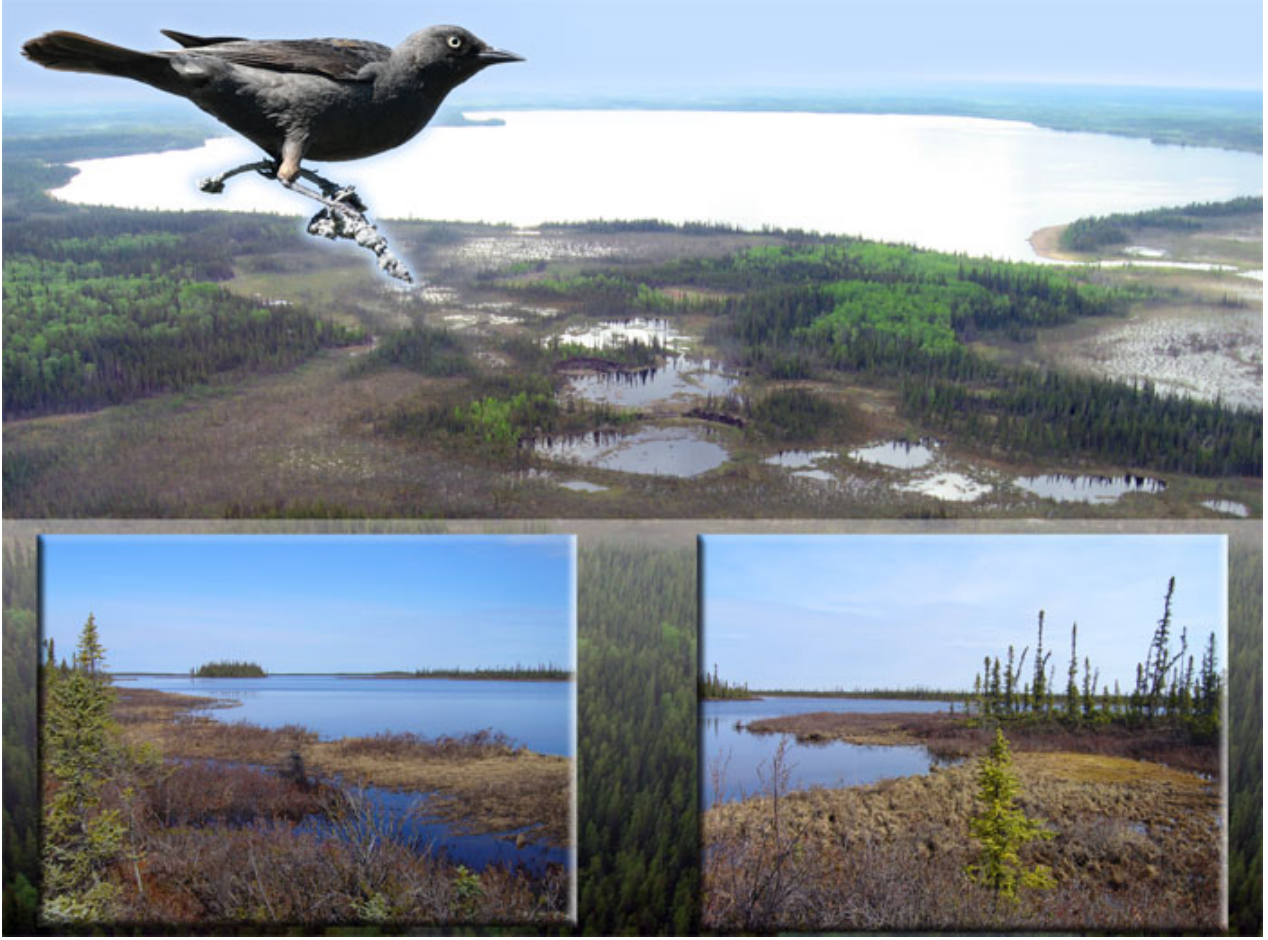
Fig. 2. Typical wetland complex composed primarily of black spruce muskeg in which Rusty Blackbirds were detected; insets depict typical shoreline attributes of occupied sites. Photo credits: main image, CSM; inset habitats, KAH; Rusty Blackbird, S.